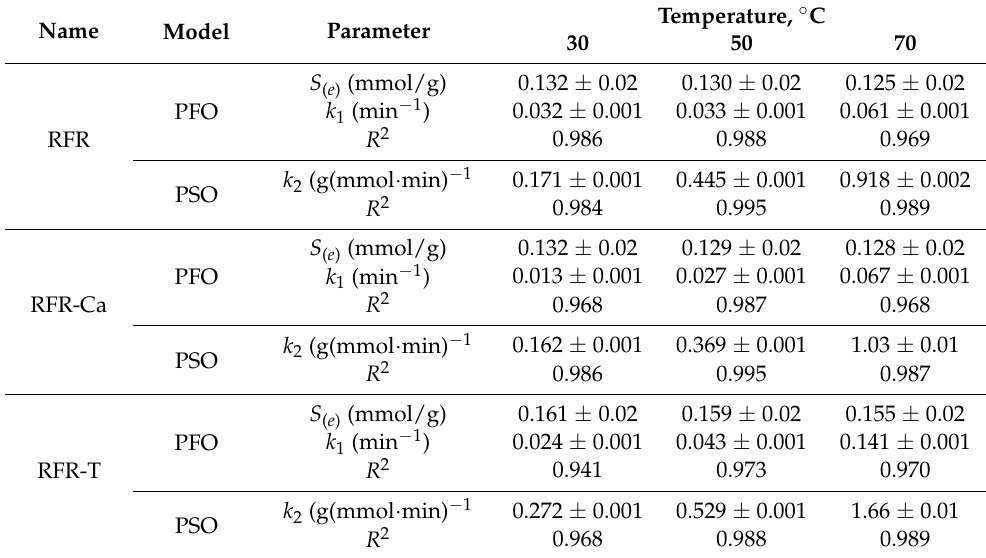
Table 2. Parameters of the pseudo-first (PFO) and pseudo-second (PSO) orders Cs-133 sorption kinetics.